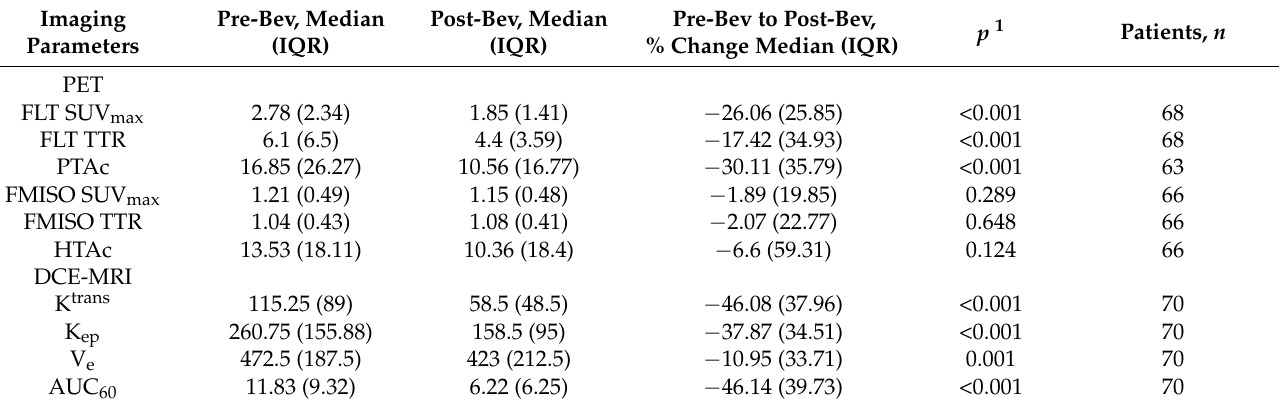
Table 3. Changes in imaging parameters from baseline until the end of treatment after cycle